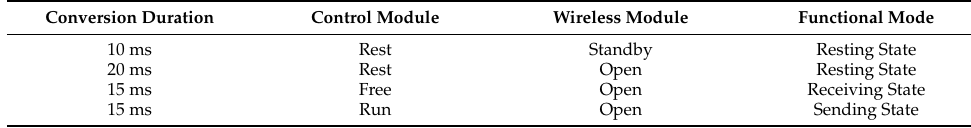
Table 2. Sensor working status module table.